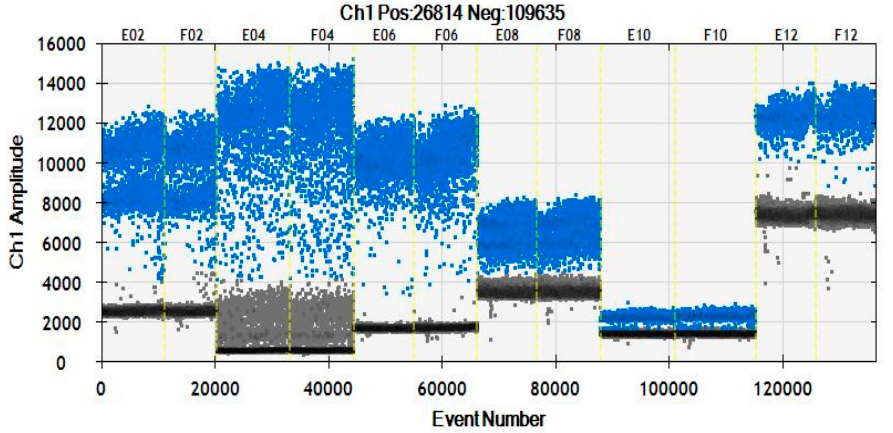
Figure 2. ddPCR amplitude plots for Brassica napus cultivar of six reference genes. Amplification of CruA , HMG , BnC1 , PEP , Fat(A) , BnAcc genes from left to right. Blue, positive droplets; black, nega- tive droplets. E02 and E04 to F12 are the detection positions in the 96-well PCR plate by